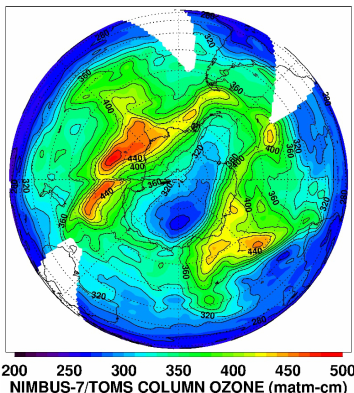
Figure 1. Southern Hemisphere image of total column ozone (TCO) from TOMS for 1 November 1978. Longitude orientation is 0 ◦ E to the right and 90 ◦ E at the bottom; latitude circles (dotted) have a spacing of 10 ◦ . White areas indicate where there are discrete data voids or no measurements. Ozone units of matm-cm are equivalent to Dobson units (DU), where 1DU is 2 . 687 × 10 20 molecules per square meter. Black contours are TCO at intervals of 20matm-cm.